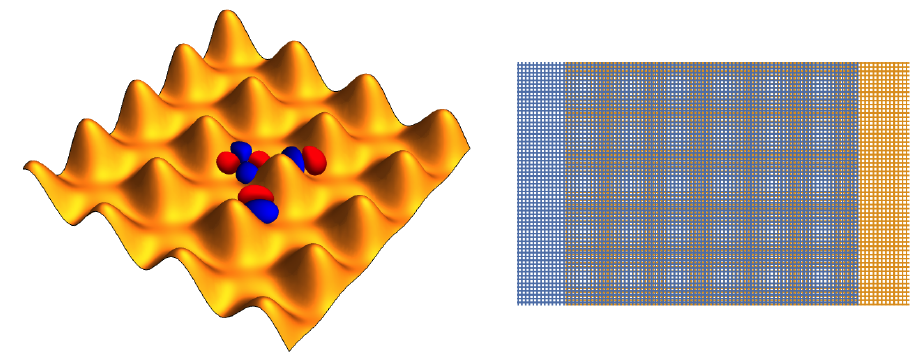
Figure 1: Multi-orbital optical lattice and moiré pattern: Schematic description of the optical lattice from Ref. [ 36 ] . The p depicted in the middle three sites, where the different color indicates the sign of the wavefunctions. The right figure shows a top view of two incommensurate square lattice, demonstrating the moiré lattice that arises due to their interference